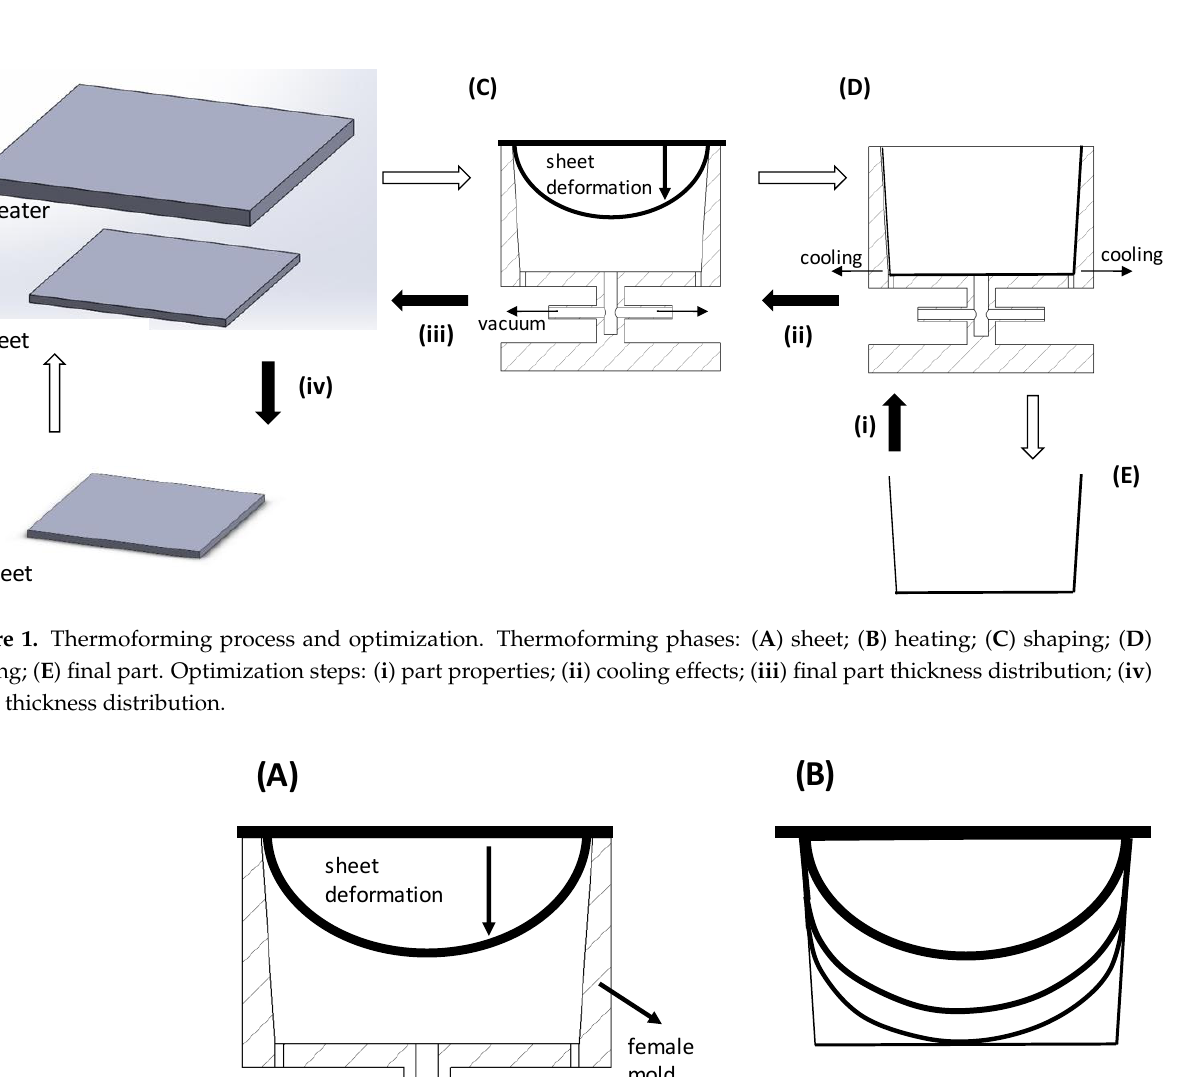
Figure 2. Thermoforming process: ( A ) sheet deformation in the mold; ( B ) evolution of the part thickness during deformation.